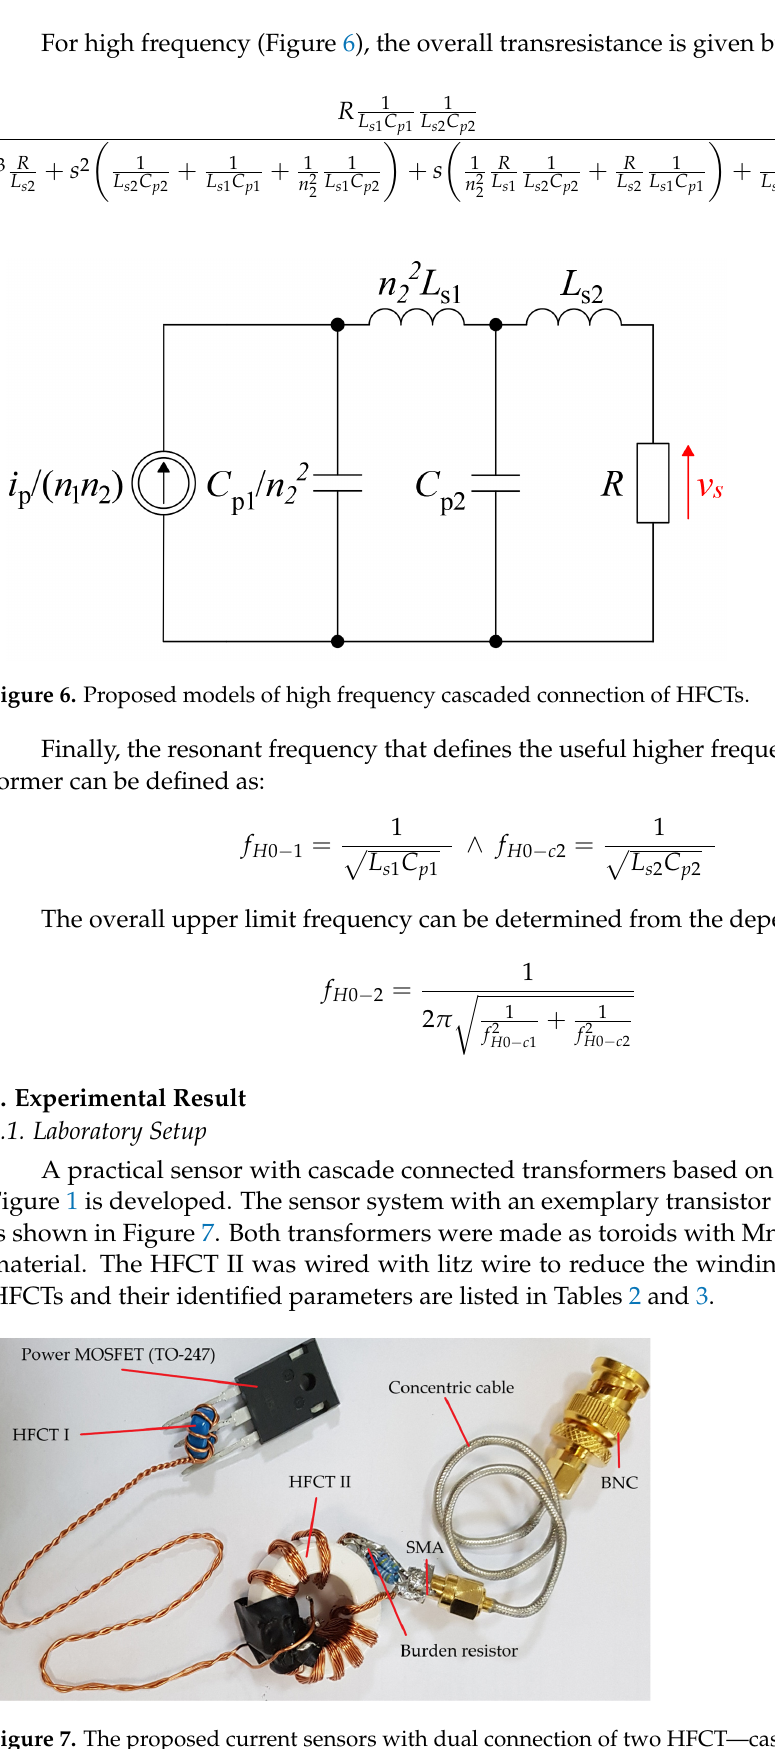
4 Table 3. Measured parameters of the HFCT II. Parameter